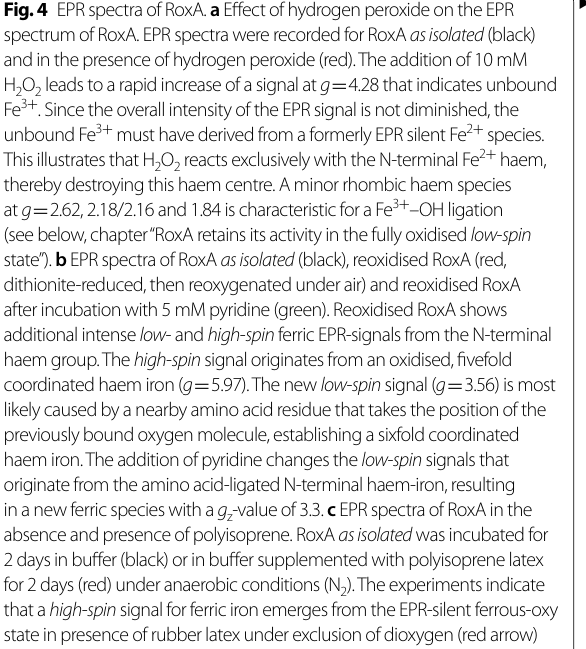
Fig. 4 EPR spectra of RoxA. a Effect of hydrogen peroxide on the EPR spectrum of RoxA. EPR spectra were recorded for RoxA as isolated (black) and in the presence of hydrogen peroxide (red). The addition of 10 mM H 2 O 2 leads to a rapid increase of a signal at g 4.28 that indicates unbound = Fe 3 + . Since the overall intensity of the EPR signal is not diminished, the unbound Fe 3 + must have derived from a formerly EPR silent Fe 2 +